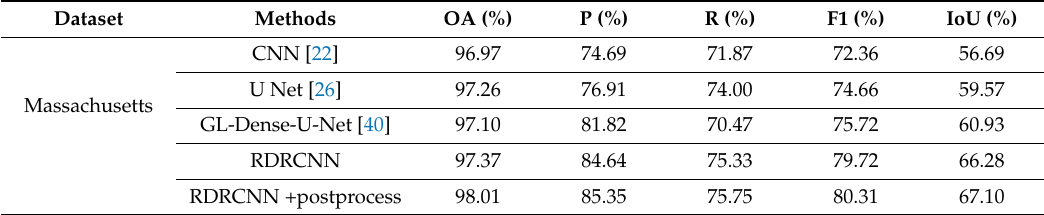
Table 6. Comparisons of the proposed and other deep-learning-based road extraction methods on the Massachusetts road test dataset in terms of better performance of